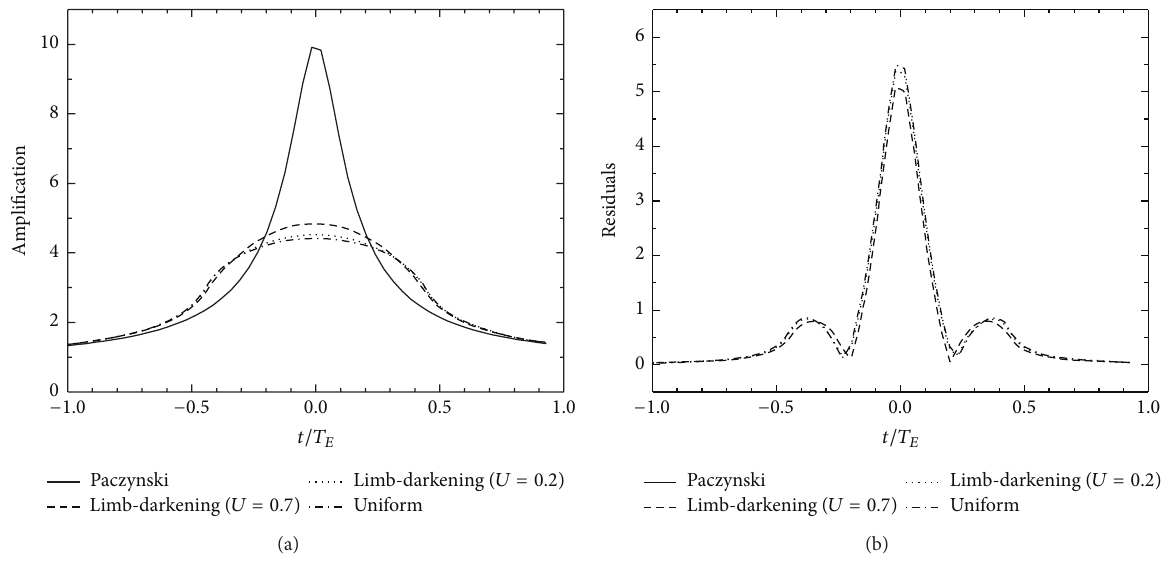
Figure 2: (a) Time variation of the amplification for a microlensing event with 𝑢 0 = 0.1 and 𝜌 ∗ = 0.46 ( 𝑢 0 < 𝜌 ∗ ) in cases: standard (continuous line) uniform source (dot-dashed line) and linear law of LCDs for 𝑈 = 0.2 (dotted line) and 𝑈 = 0.7 (dashed line). Increasing 𝑈 enhances the limb-darkening effects and thus brings the finite source light curve closer to Paczynski formalism. (b) The residual curves between the Paczynski and the curves with finite source effect are shown. The time is given in units of the Einstein time of the event.